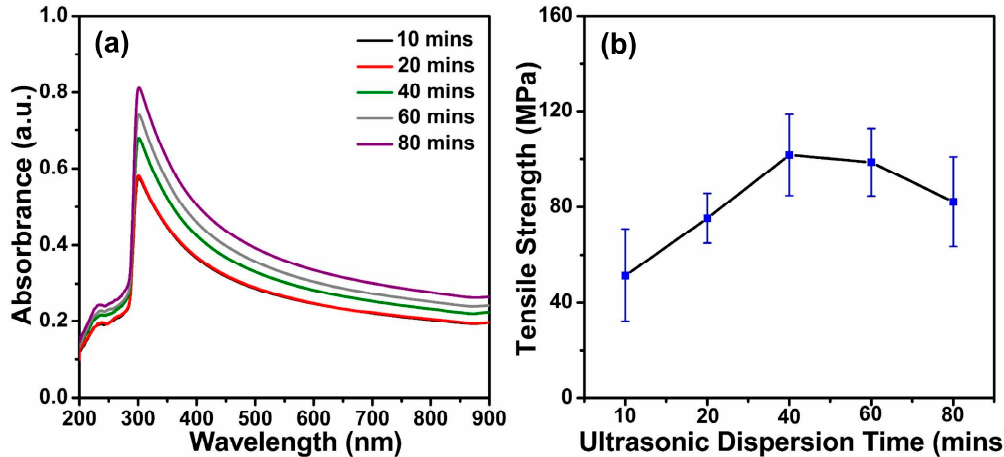
Figure 4. The UV–Vis spectra and tensile strength of the HA/MWCNT hybrid microfibers prepared by HA/MWCNT dispersions with different ultrasonication times. ( a ) UV-Vis spectra; ( b ) Tensile strength results.